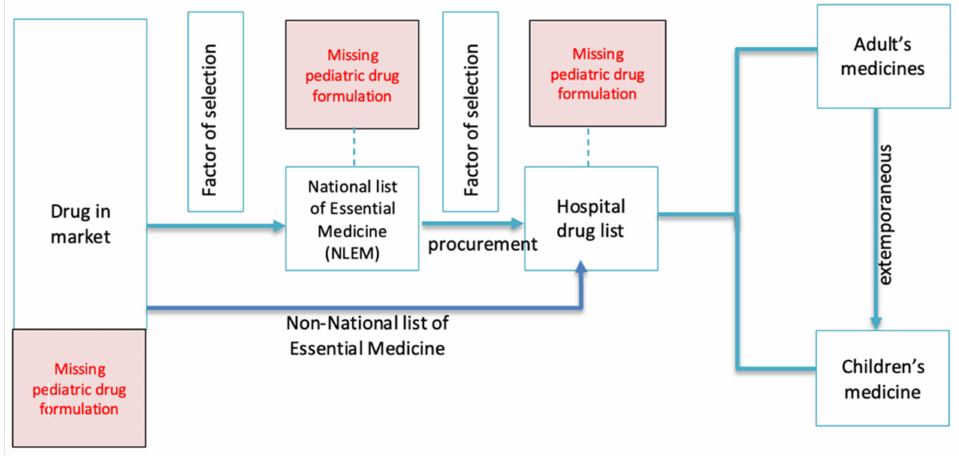
Figure 1. Gaps in the accessibility to pediatric formulations in